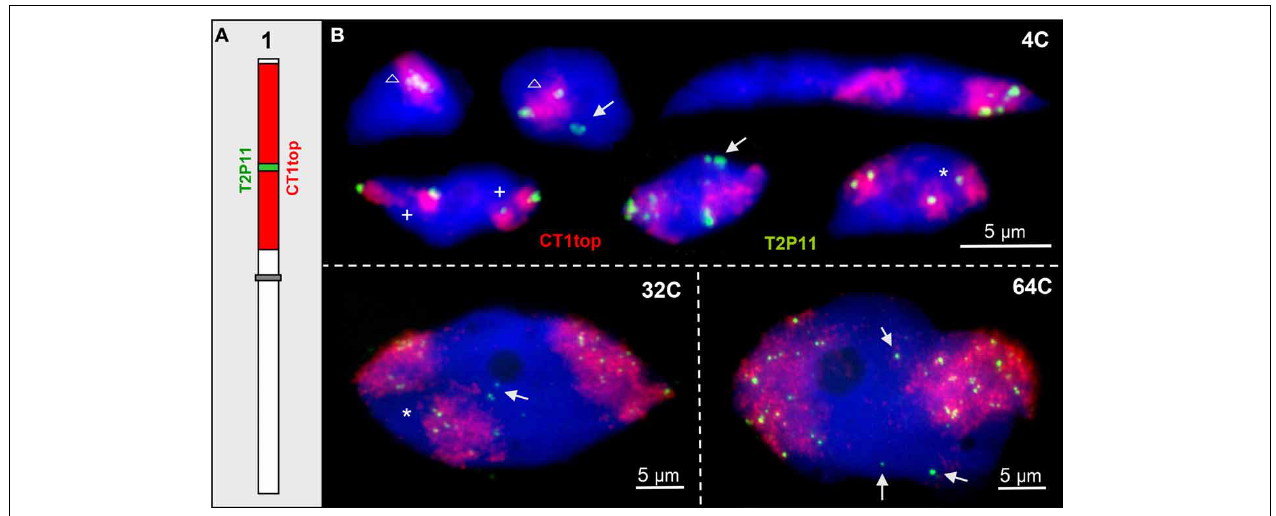
FIGURE 2 | ∼ 85kb euchromatin segments may loop out from their CTs. (A) Scheme of chromosome 1 showing the labeling of CT1top arm, and BAC T2P11 therein in different color as used for FISH. (B) Examples of chromatin configurations in 4C, 32C, and 64C nuclei. Sister chromatid territories of one (asterisks) or both (cross)